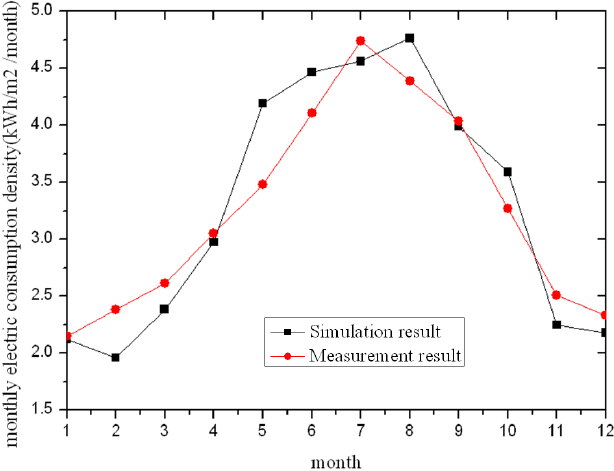
Figure 3. Comparison between eQUEST simulation and the measured results.